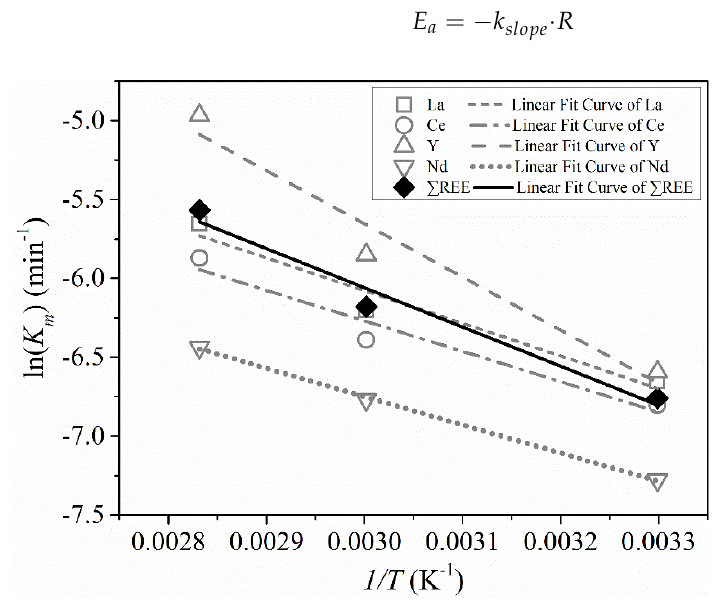
Figure 14. Arrhenius plots of leaching REEs from cylindrical PG under control of interfacial transfer and diffusion across the product layer.